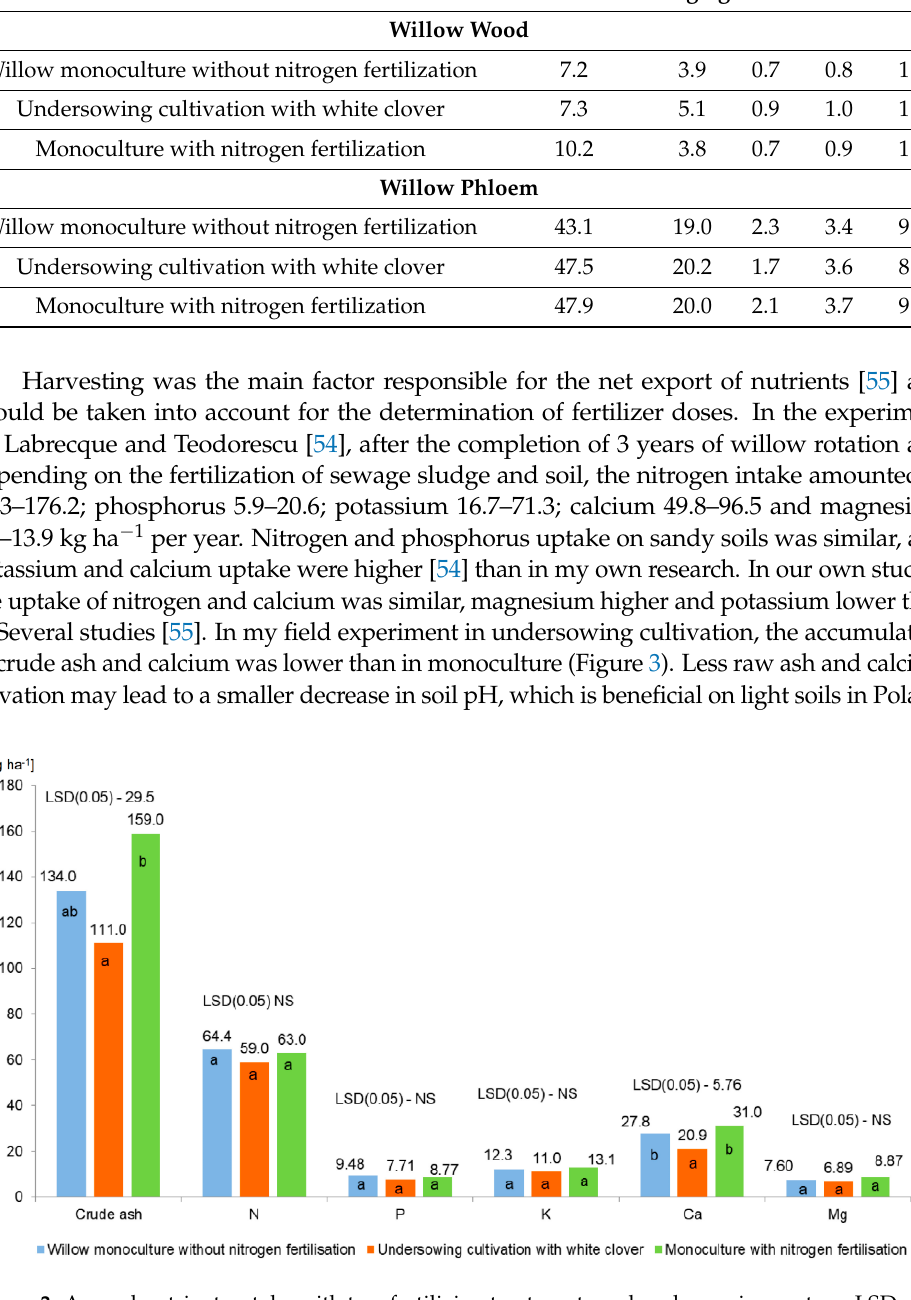
Figure 3. Annual nutrient uptake with two fertilizing treatments and undersowing system. LSD—the least significant difference. NS—difference is not significant. Different letters indicate significant differences between treatments (Tukey’s multiple range test).